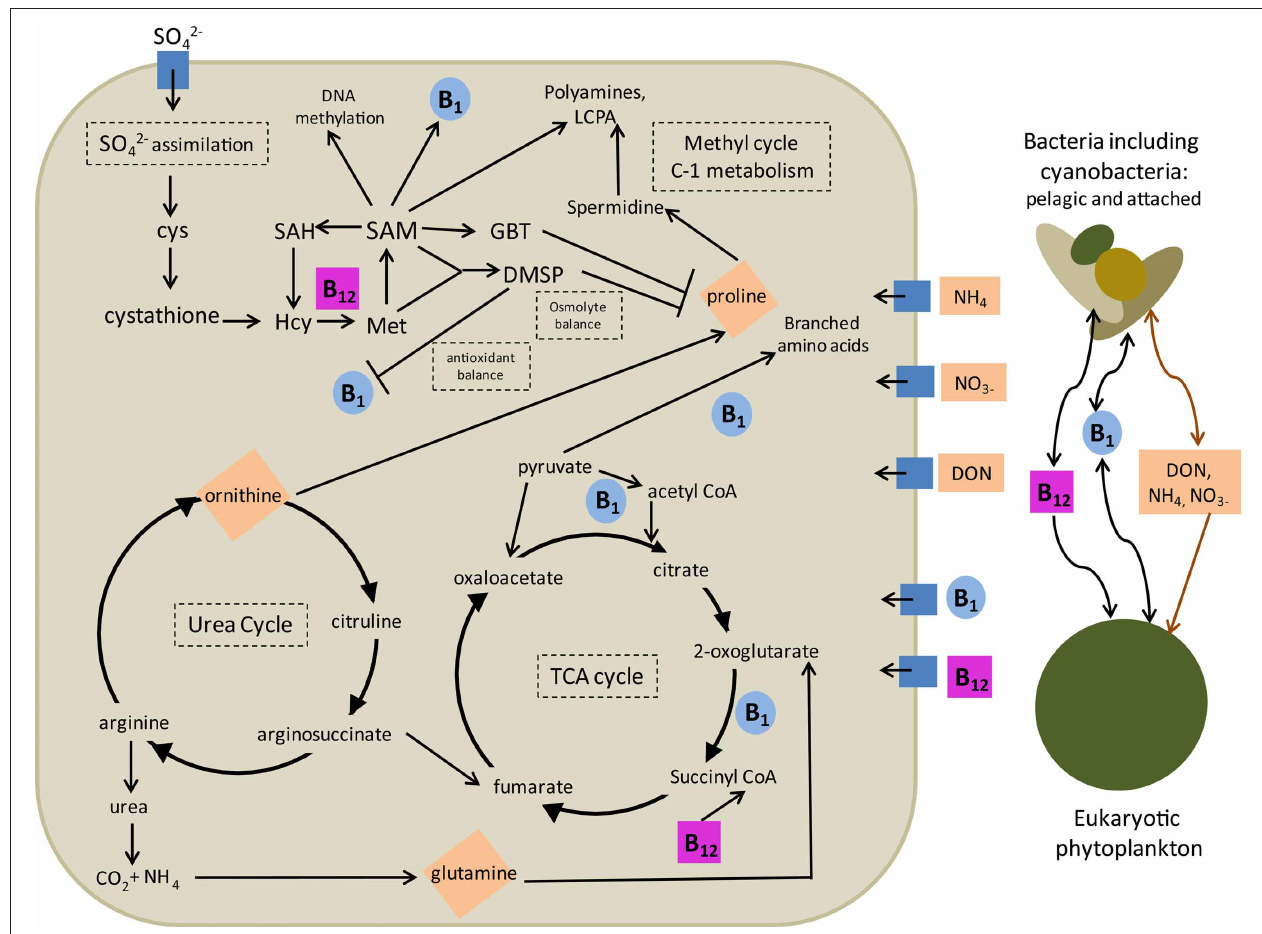
FIGURE 4 | An overview of B 12 and B 1 interactions with nitrogen metabolism in eukaryotic phytoplankton. Four major intracellular mechanisms are outlined: (1) impacts on osmolyte and antioxidant production and utilization and (2) impacts on polyamine biosynthesis via the methyl cycle, (3) impacts on the urea cycle and amino acid recycling through impacts on the citric acid cycle, and (4) impacts of nitrogen balance on sulfur assimilation. Major cellular nitrogen stores impacted by B 1 and B 12 availability are shown in orange diamonds. Arrows denote direction of reaction, production, or consumption. Bars denote potential negative feedbacks,